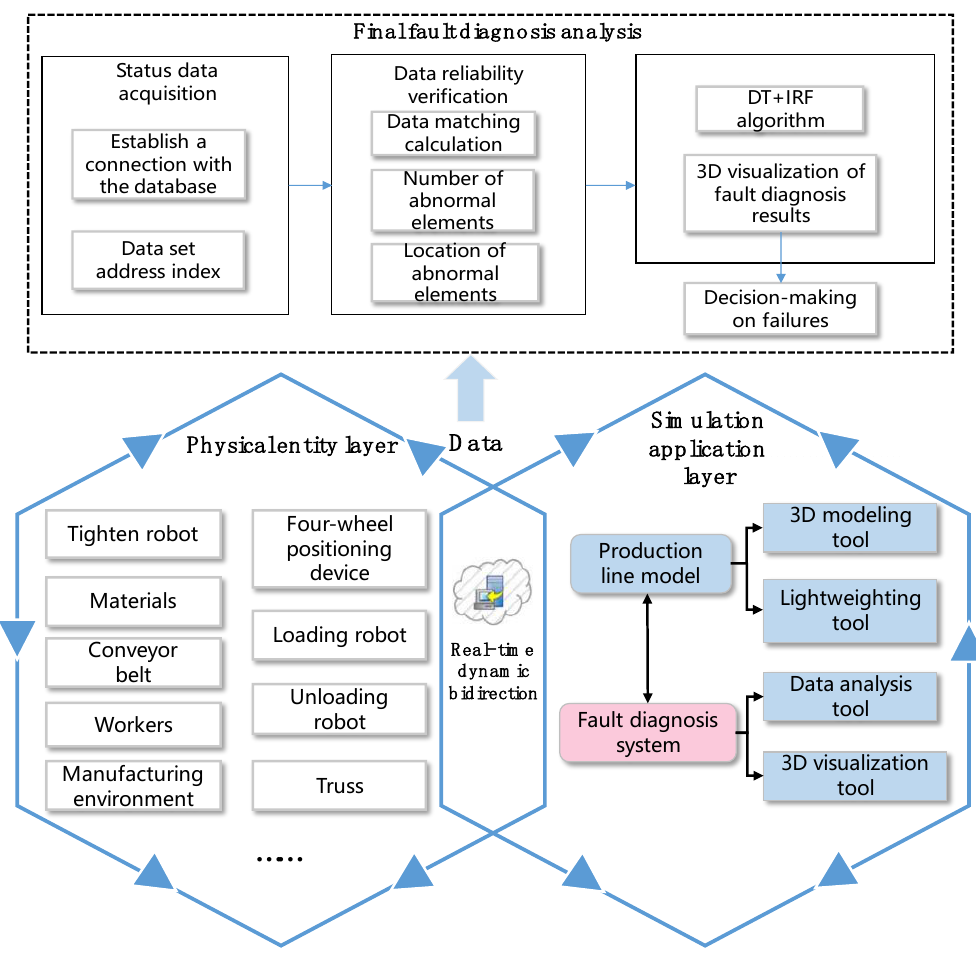
Figure 1. The framework of a fault diagnosis system.